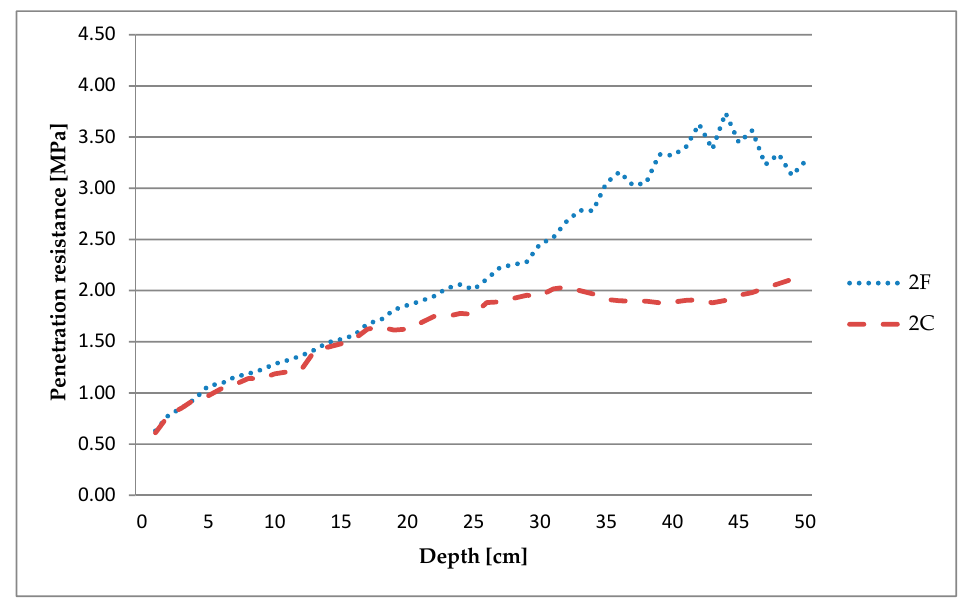
Figure 3. Soil compaction at sites 1F and 1C.